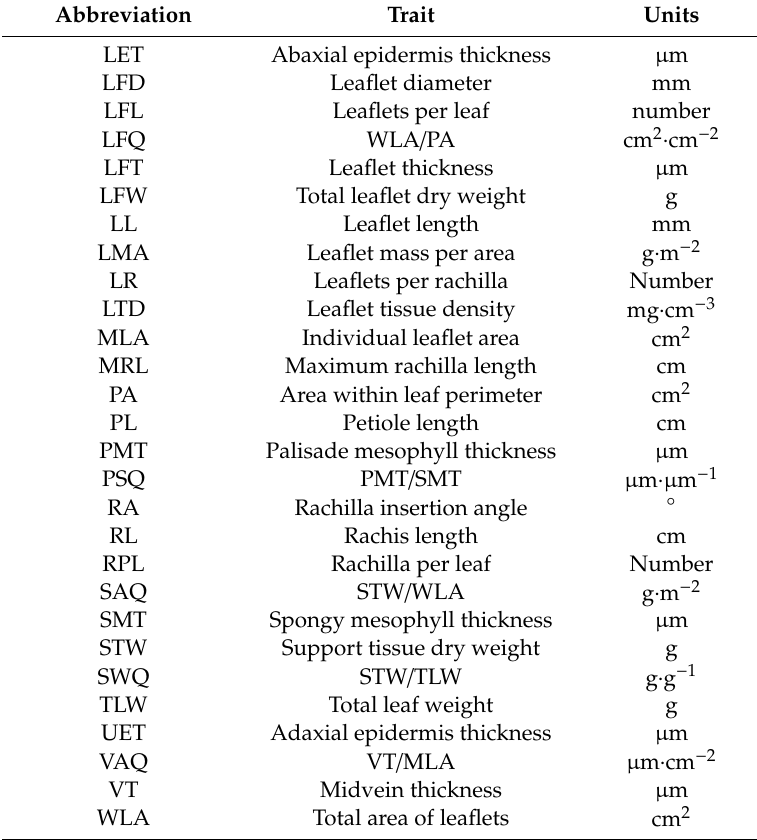
Table 1. Abbreviations and units for Serianthes nelsonii leaf and leaflet